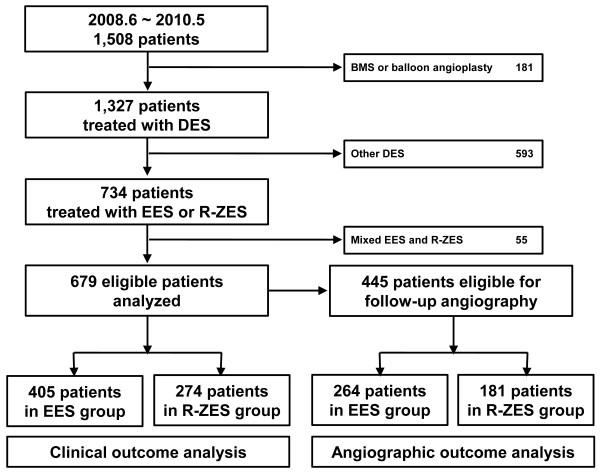
Flow of participants diagram. Abbreviations: EES, everolimus-eluting stent; R-ZES, Resolute zotarolimus eluting-stent.